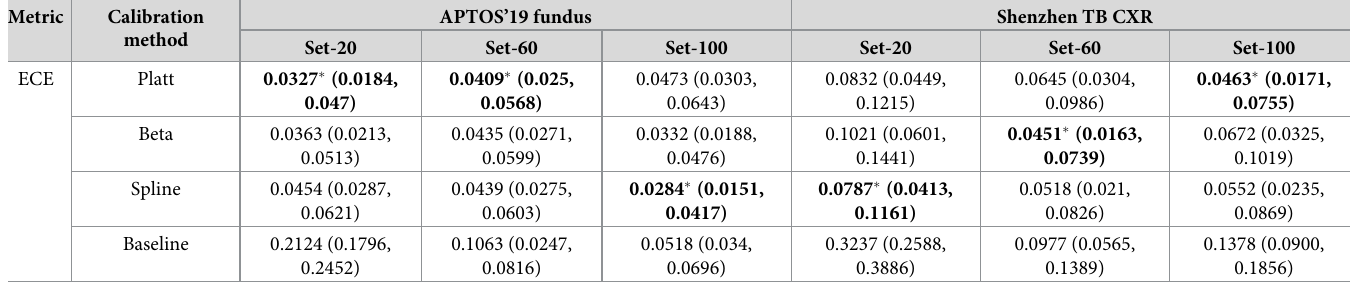
Table 3. ECE metric achieved by the DenseNet-121 and VGG-16 models that are respectively retrained on the Set-20 and Set-60 datasets, individually from APTOS’19 fundus (n = 600) and Shenzhen TB CXR (n = 200) data collections. Metric